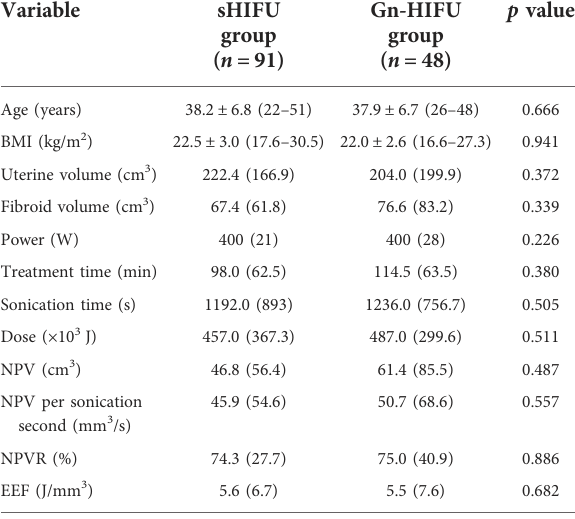
TABLE 3 Comparison of baseline and ultrasound ablation results between the sHIFU group and the Gn-HIFU group after cohort